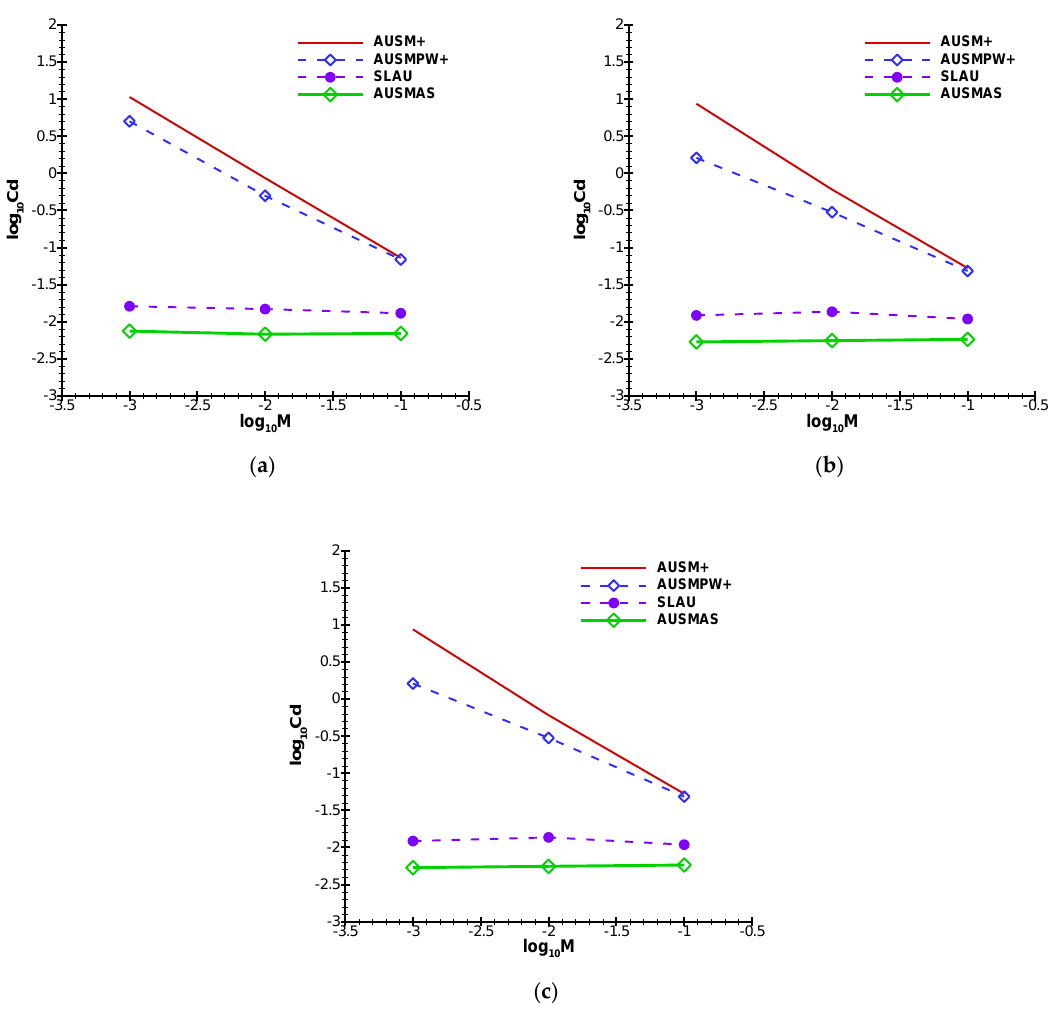
Figure 14. Drag coefficients vs. inflow Mach number (coarse grid, ( a ) first order reconstruction, ( b ) second order reconstruction, ( c ) third order reconstruction).